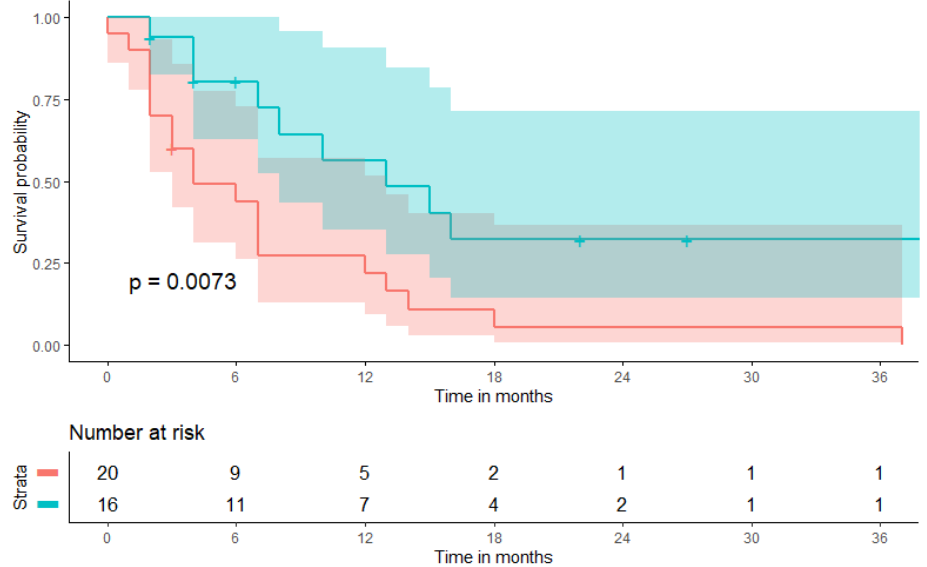
Figure 4. Kaplan-Meier curve depicting progression-free survival (PFS) with confidence interval estimates at the timepoint of pembrolizumab therapy initiation broken down by pretherapeutic body mass index. The blue line depicts the cohort with a pretherapeutic BMI ≥ 25 kg/m 2 , the red line depicts the cohort with a pretherapeutic BMI < 25 kg/m 2 .